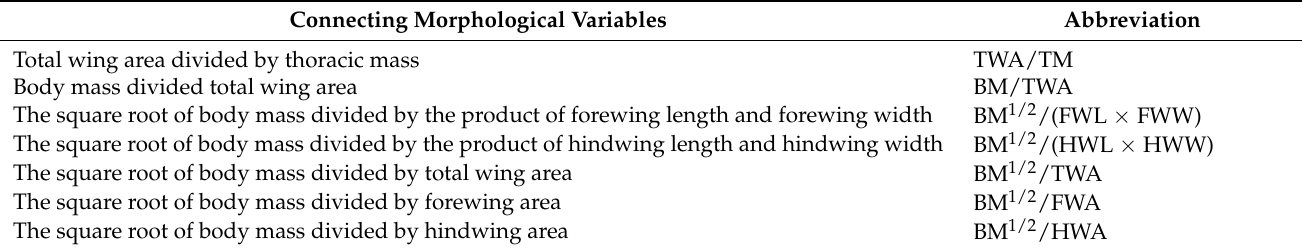
Table 2. Seven connecting morphological variables measured in this